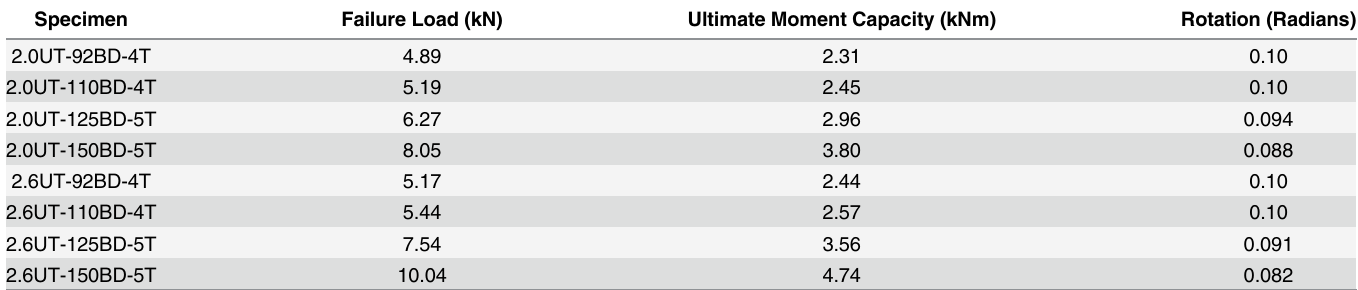
Table 5. Average test